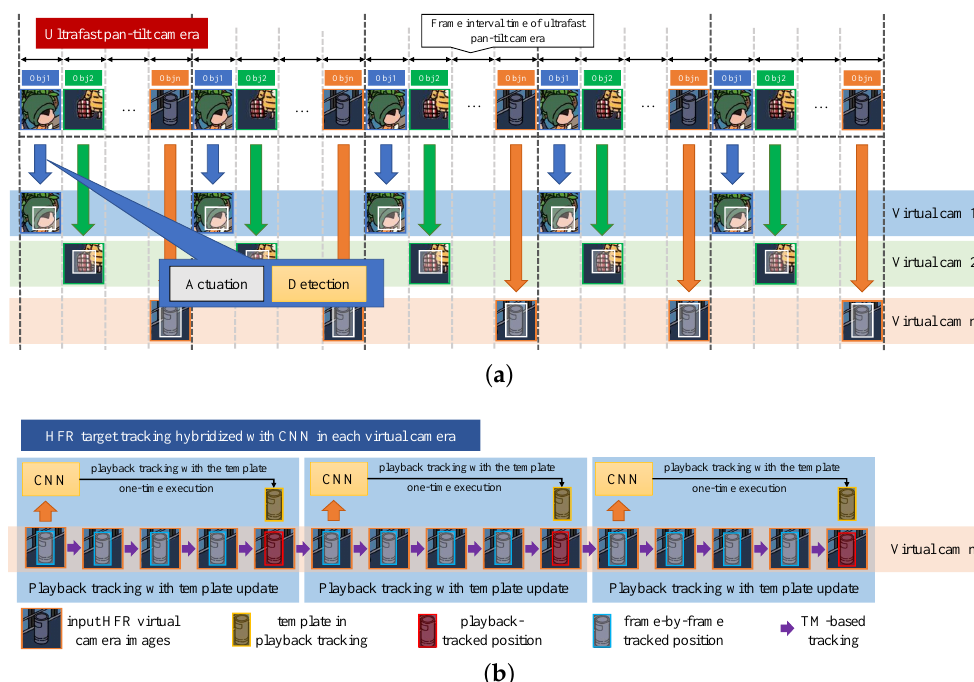
Figure 4. Time-division threaded gaze control process for multiple target tracking based on HFR ob- ject detection hybridized with CNN: ( a ) time-division threaded gaze control process for simultaneous multi-object observation and ( b ) HFR target tracking hybridized with CNN in each virtual